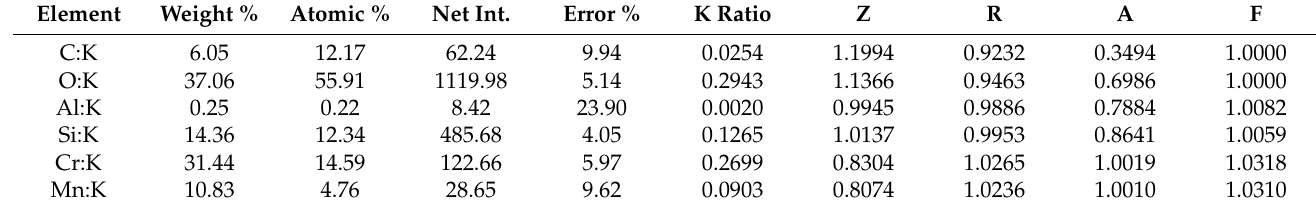
Table 5. Chemical composition as the result of EDS analysis in specimen No. 5 (first point).